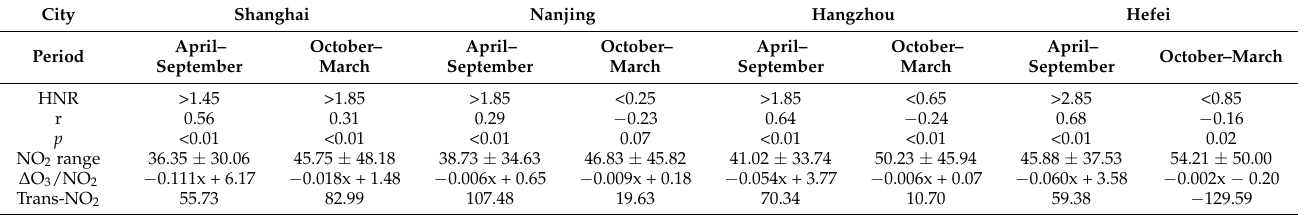
Figure 7. Separation for the relationship between Δ O 3 and NO 2 concentration by HCHO/NO 2 ratio (HNR) from Sentinel-5P measurements during April – September (top panel) and October – March (bottom panel) over four capital cities ( a , e ) Shanghai; ( b , f ) Nanjing; ( c , g ) Hangzhou; ( d , h ) Hefei in the Yangtze River Delta. Table 3. HCHO/NO 2 ratio (HNR) thresholds, relationships between ∆ O 3 and NO 2 ( µ g · m − 3 ) and Δ O 3 variation rate to NO 2 change with measurements from the dense network and Sentinel-5P observations over four capital cities in the Yangtze River Delta.